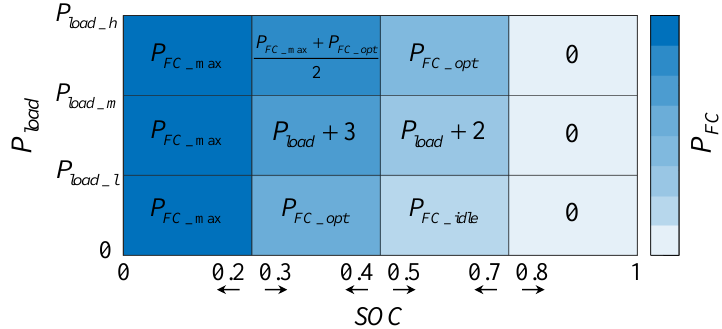
Figure 2. Rule-based energy management